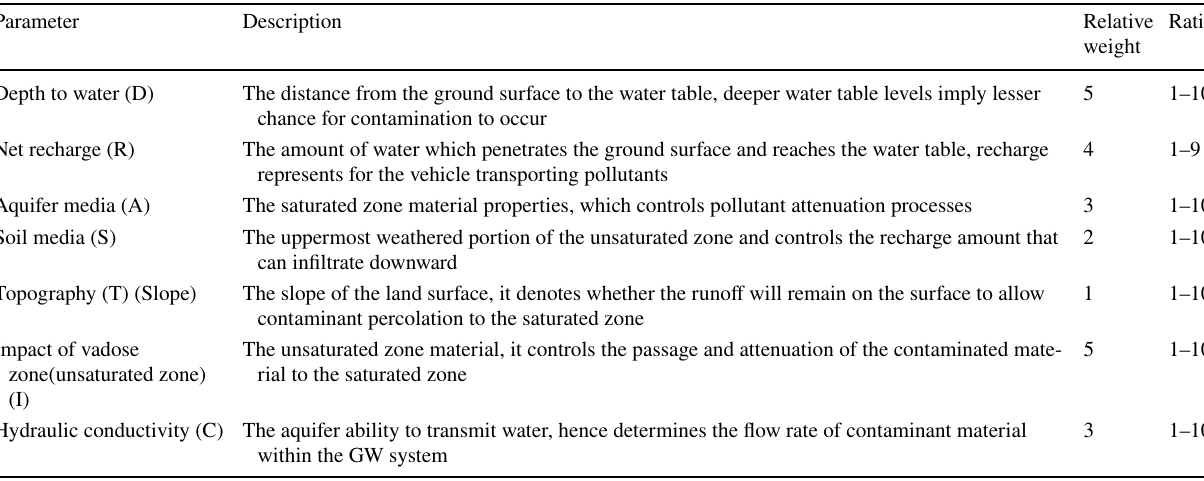
Table 1 The parameters of DRASTIC method (Aller et al.